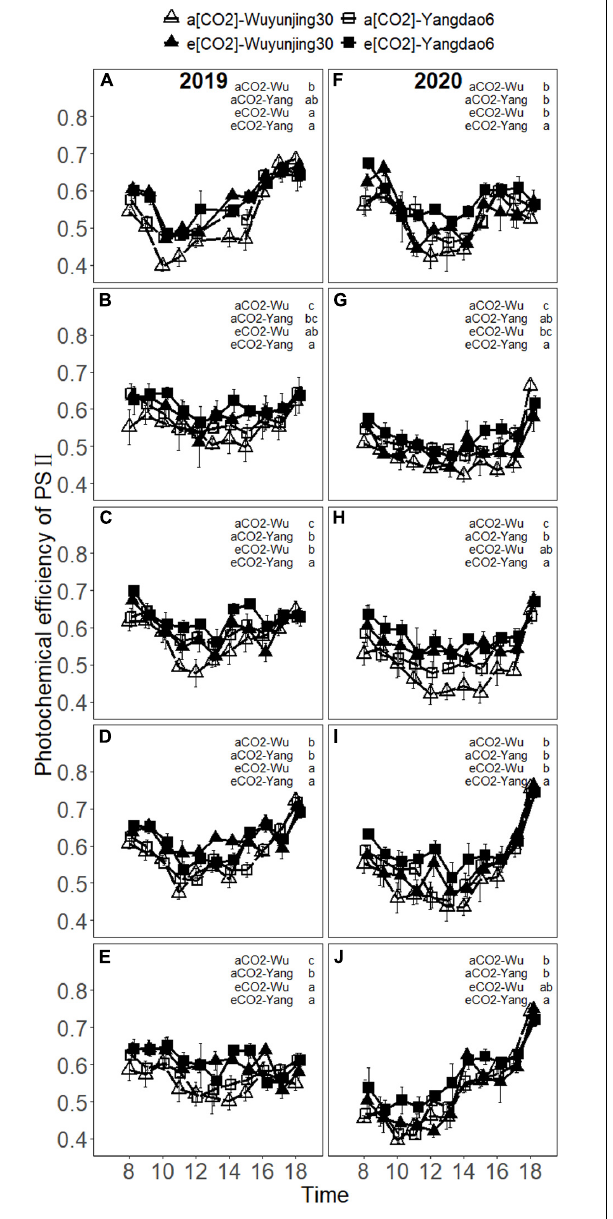
FIGURE 3 | Diurnal variations in stomatal conductance (g s ) of rice cultivar Wuyunjing30 and Yangdao6 grown at ambient and elevated (CO 2 ) at jointing (A,F), booting (B,G) , heading (C,H) , grain-filling (D,I), and maturity (E,J) stages in 2019 and 2020. Values were expressed as means ± standard errors form. Values of g s under four (CO 2 ) × cultivar treatments at 13 p.m. at jointing stage in 2019 were deleted because of the abnormal values found by examination. Statistical analyses of multiple comparisons for five growing stages in 2 years were shown in each panels of the figure in the form of lowercase letters.